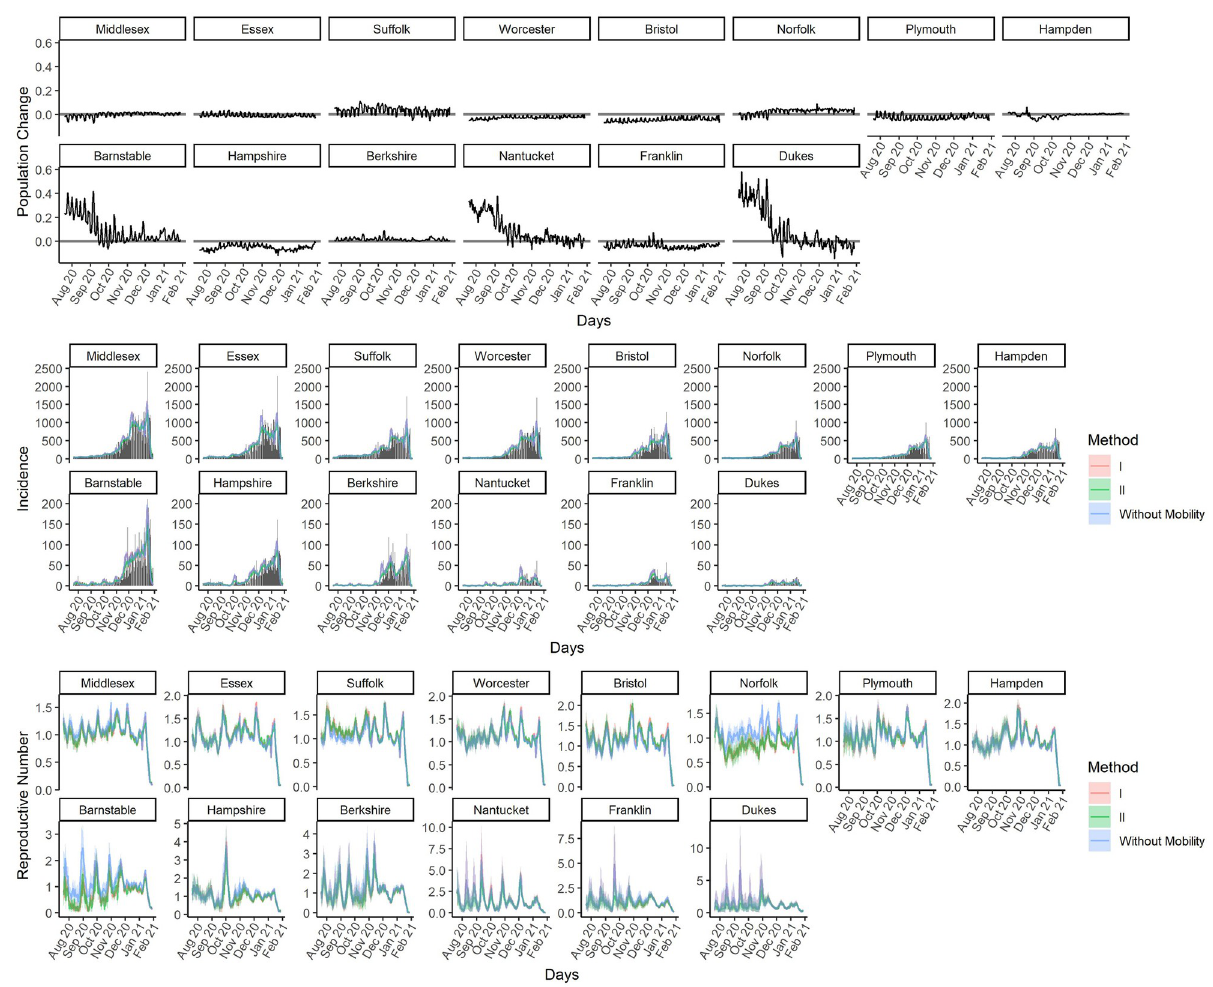
Fig 6. Population change, estimated Incidence and R ( t ) for all MA counties. Solid lines are the posterior means for incidence and R ( t ), along with the 95% credible band. The bar plots for the observed incidence are also shown. Results from Approach I, the incidence adjustment approach, are in red and those from Approach II, the Bayesian approach, are in green, and those from the original Fraser’s method (obtained by Approach II without incorporating mobility data) are in